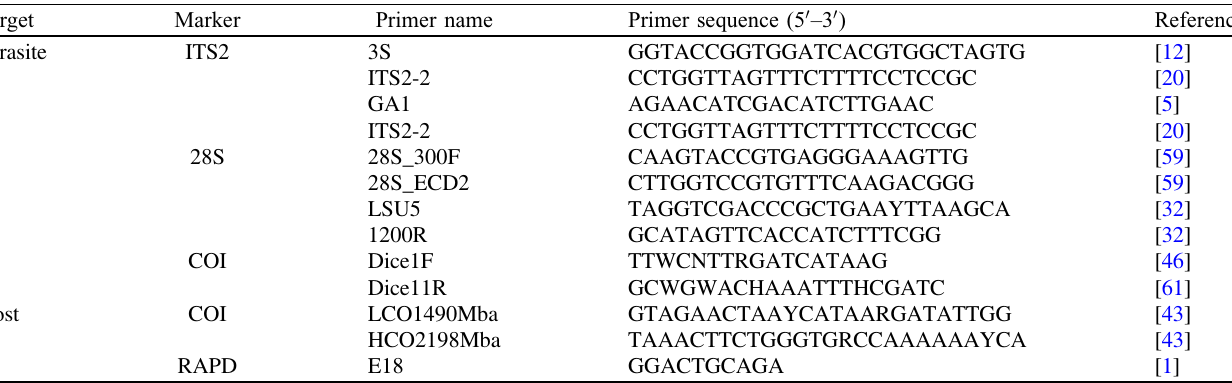
Table 1. Primer and randomly ampli fi ed polymorphic DNA (RAPD) sequences used in this study.